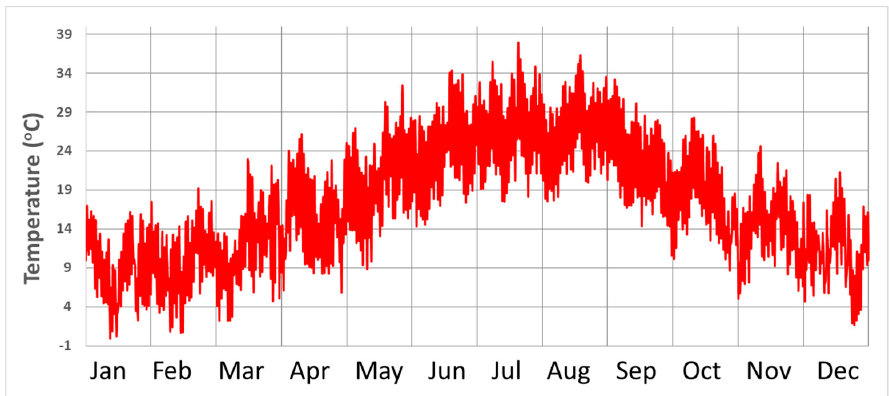
Figure 2. Ambient temperature of the whole year.